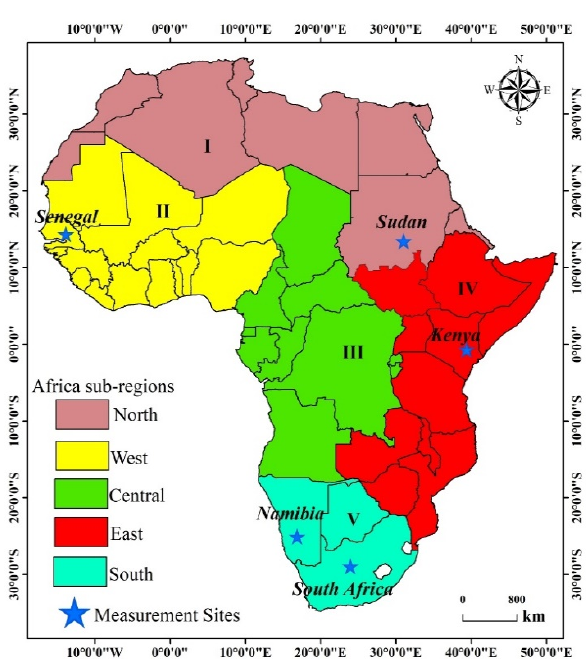
Figure 1. Overview of the station locations and study regions across Africa: north (I), west (II), central (III), east (IV), and south (V).